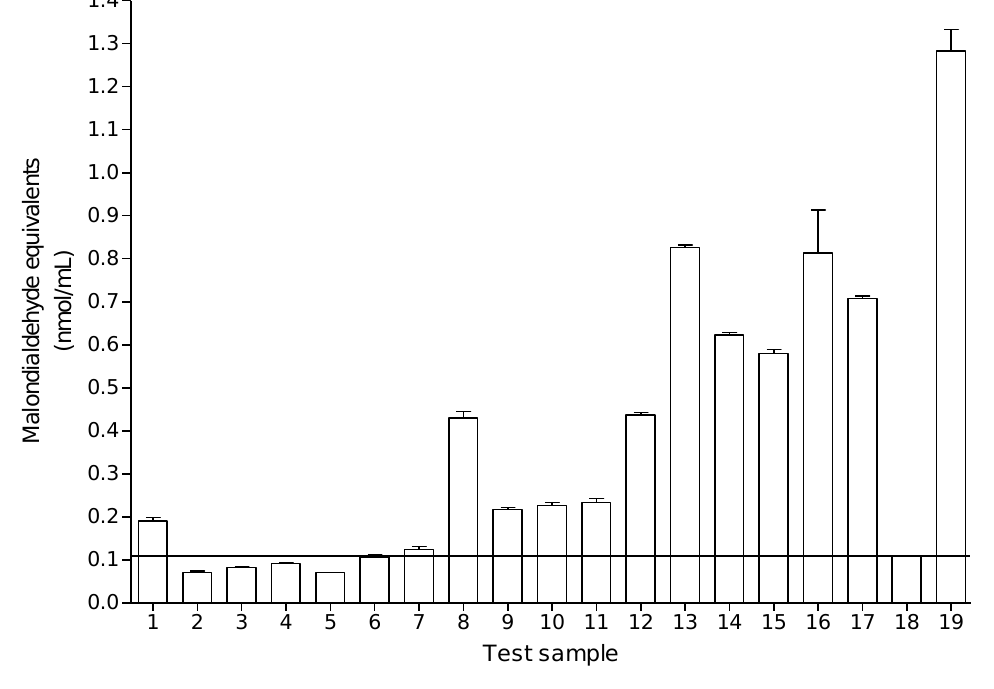
Figure 3. Malondialdehyde (MDA) equivalents (nmol/mL) recovered from the peroxidation of phospholipid in the presence of test samples. Isolated compounds were tested at 350 µg/mL while the crude extracts, fractions and ascorbic acid were tested at 3.5 mg/mL. Helichrysoside-3'-methyl ether ( 1 ), tiliroside ( 2 ), isovitexin ( 3 ), combination 1 (helichrysoside-3'-methyl ether + tiliroside + isovitexin) ( 4 ), combination 2 (helichrysoside-3'-methyl ether + tiliroside) ( 5 ), combination 3 (helichrysoside-3'-methyl ether + isovitexin) ( 6 ), combination 4 (tiliroside + isovitexin) ( 7 ), C. gratissimus crude 20% methanol extract ( 8 ), C. gratissimus hexane fraction ( 9 ), C. gratissimus DCM fraction ( 10 ), C. gratissimus ethyl acetate fraction ( 11 ), C. gratissimus butanol fraction ( 12 ), C. zambesicus crude 20% methanol extract ( 13 ), C. zambesicus hexane fraction ( 14 ), C. zambesicus DCM fraction ( 15 ), C. zambesicus ethyl acetate fraction ( 16 ), C. zambesicus butanol fraction ( 17 ), ascorbic acid (positive control) ( 18 ) and water (negative control) ( 19 ). Lower amounts of MDA, signifies higher protective ability of extract against lipid peroxidation. Values represent mean ± standard error (n = 2).